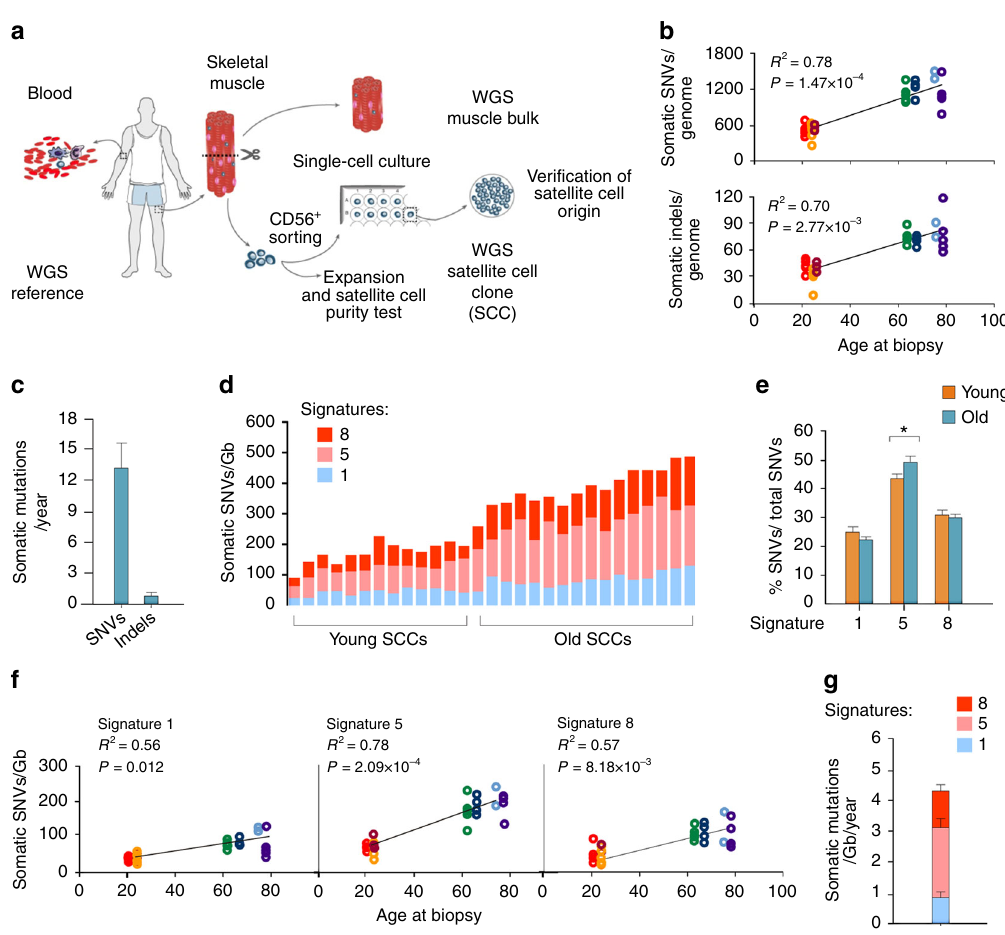
Fig. 1 Age-related increase of somatic mutations in satellite cells. a Experimental strategy for somatic variant detection with whole-genome sequencing (WGS). The reference sequence was obtained from the blood of every individual. The muscle vastus lateralis was sequenced as a population (muscle bulk) or used to isolate CD56 + cells. These were either tested to verify the percentage of satellite cells or single cell plated and sequenced as a clonal population (SCCs) in order to detect cell-speci fi c somatic mutations. The satellite cell origin of sequenced SCCs was tested in all clones that produced a suf fi cient number of cells (21/29) b Total number of somatic single-nucleotide variants (SNVs) and insertion/deletions (indels) per SCC normalized to the percentage of autosomes covered by the sequencing. The linear fi t of mutation numbers and age is shown. P -values are calculated using a robust mixed model. Different colors correspond to the donors. c Average number of SNVs and indels accumulated per year by the SCCs according to the linear fi t shown in b . d Absolute contribution of signatures 1, 5, and 8 to the mutation catalogue of each SCC. e Average percentage of SNVs/total SNVs for the most relevant signatures in young and old SCCs. * P < 0.05 two-sided t -test. f Linear fi t of cancer signatures 1, 5, and 8 with the age of the SCCs. P -values were calculated with a robust mixed model with Bonferroni correction for multiple testing of different signatures ( n = 3). g Yearly increase in the selected cancer signatures obtained by the linear fi ts in f was plotted as a proportion of the total number of SNVs/Gb accumulating